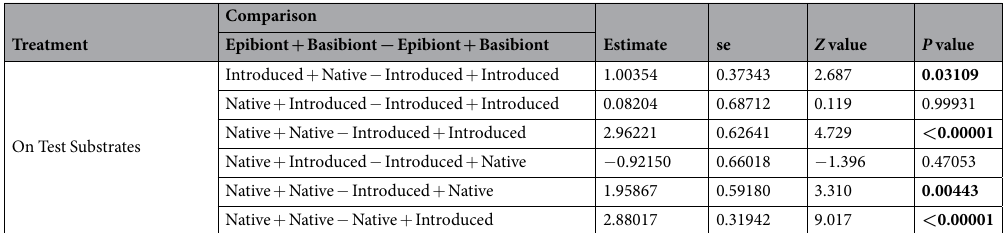
Table 1. Results of Tukey contrasts following a generalised mixed effects model comparing bryozoan larval settlement as epibionts on encrusting bryozoan basibionts.